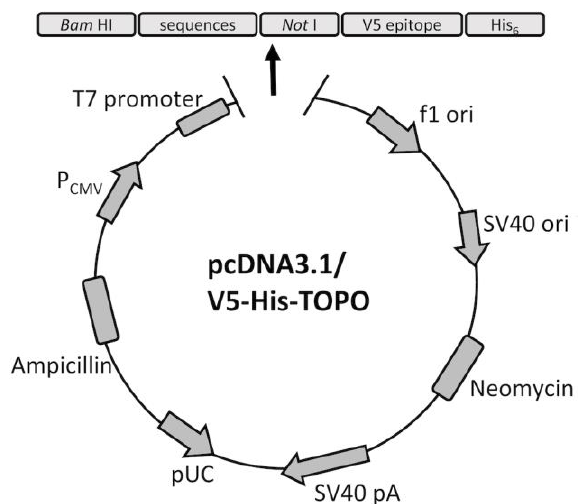
Figure 1. The construction diagram of the porcine CC chemokine proteins. The vector, pcDNA3.1/V5-His-TOPO, was composed of a human cytomegalovirus (CMV) promoter (PCMV), ampicillin and neomycin (G418) resistance genes, pUC-derived origin, a SV40 promoter, f1 origin, and the bovine growth hormone (BGH) polyadenylation signal, including a T7 promoter for in vitro transcription. The porcine CCL27, CCL28, or CCL25 sequences were cloned between restriction enzymes, BamHI and NotI. The V5 epitope and C-terminal polyhistidine tag (His 6) were included for purification of the recombinant proteins.